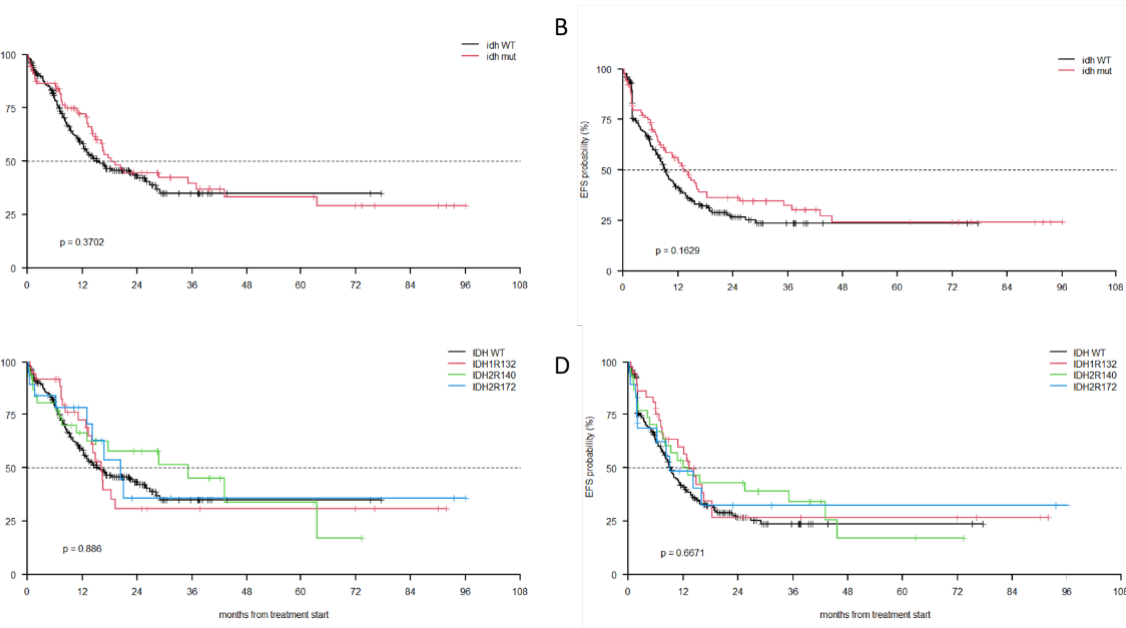
according to the IDH mutation type (IDH1-R132 vs. IDH2-R140 vs. IDH2-R172 vs. IDH-